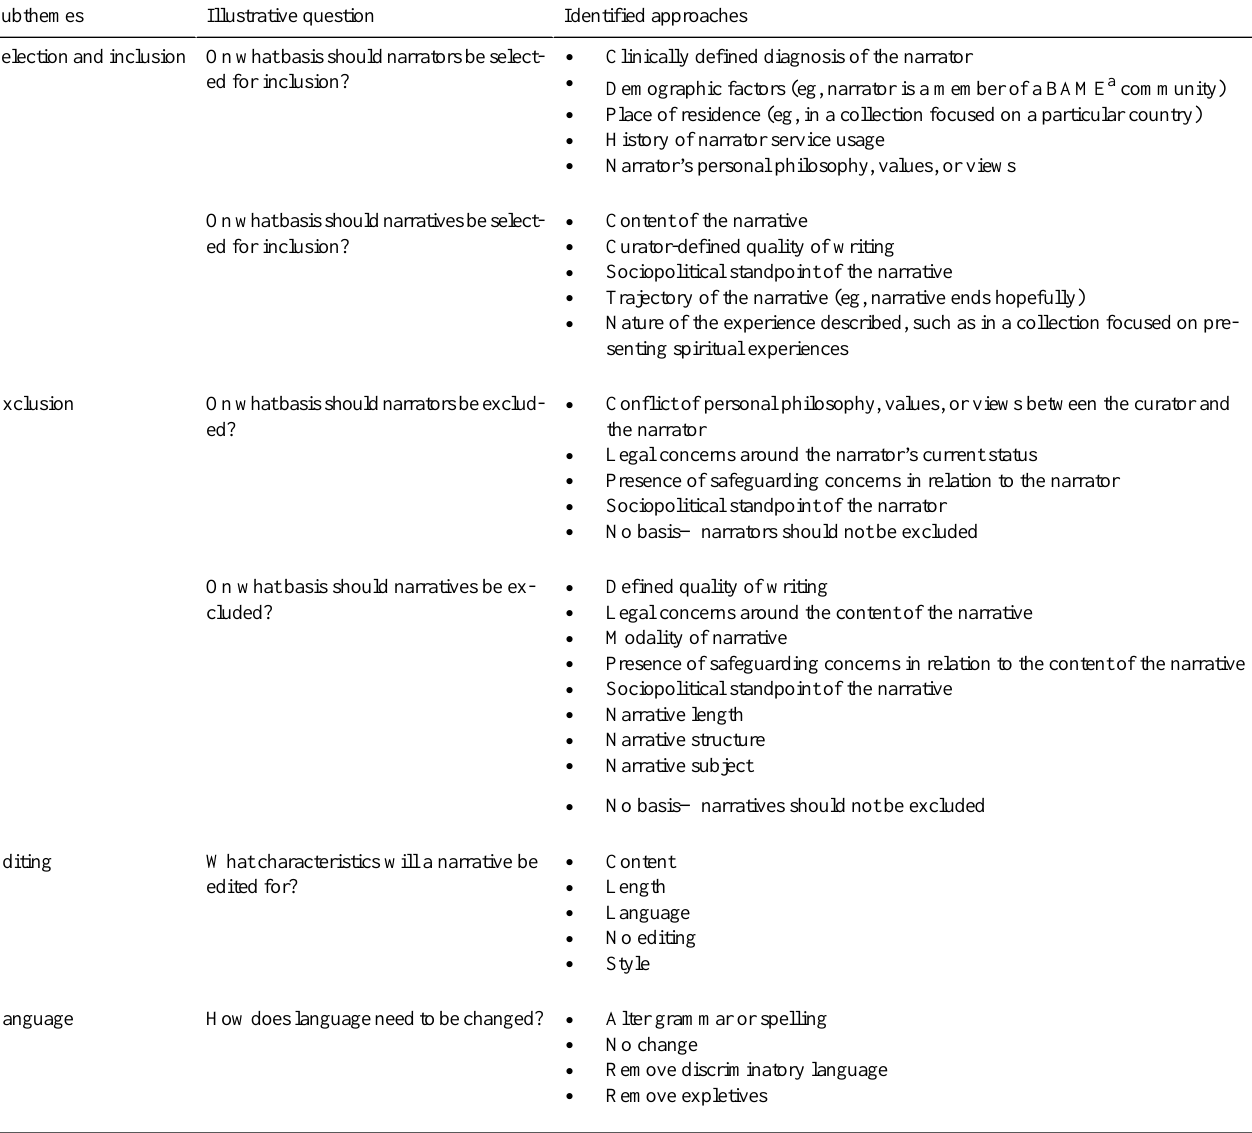
Table 4. Selection, inclusion and exclusion of narratives, narrators, and